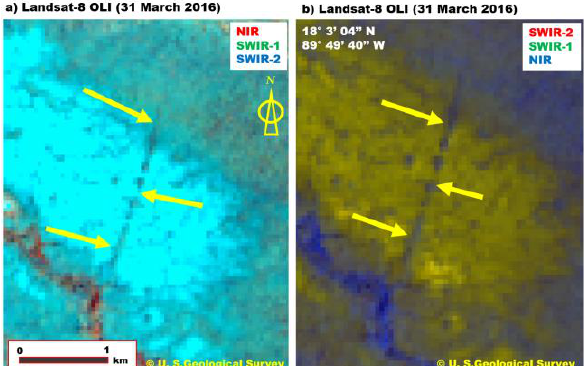
Figure 5. Sacbe segment #7 of Folan et al. (1995) located inside a bajo , as displayed: a) on the Landsat-8 OLI false-colour composite made with the image acquired in March 2016 (near-infrared band in red, first shortwave infrared band in green, and second shortwave infrared band in blue) and b) on a Landsat-8 OLI false-colour composite made with the same image (second shortwave infrared band in red, first shortwave infrared band in green, and near- infrared band in blue).